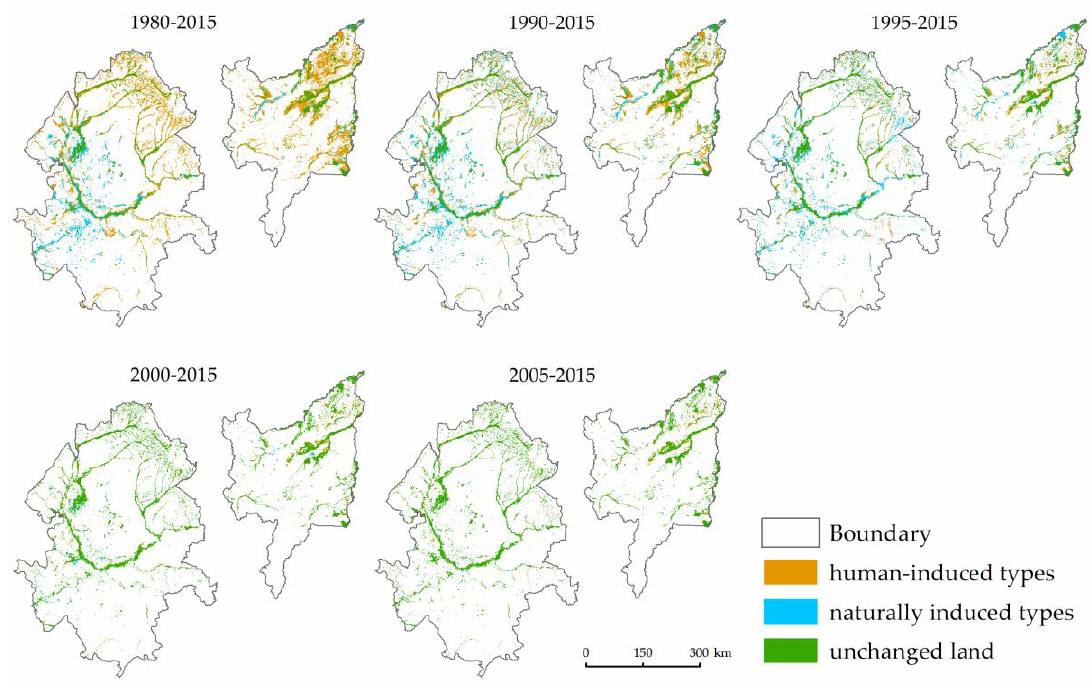
Figure 4. Spatial variations of LULCC types for five different periods over the SJP and SNP.